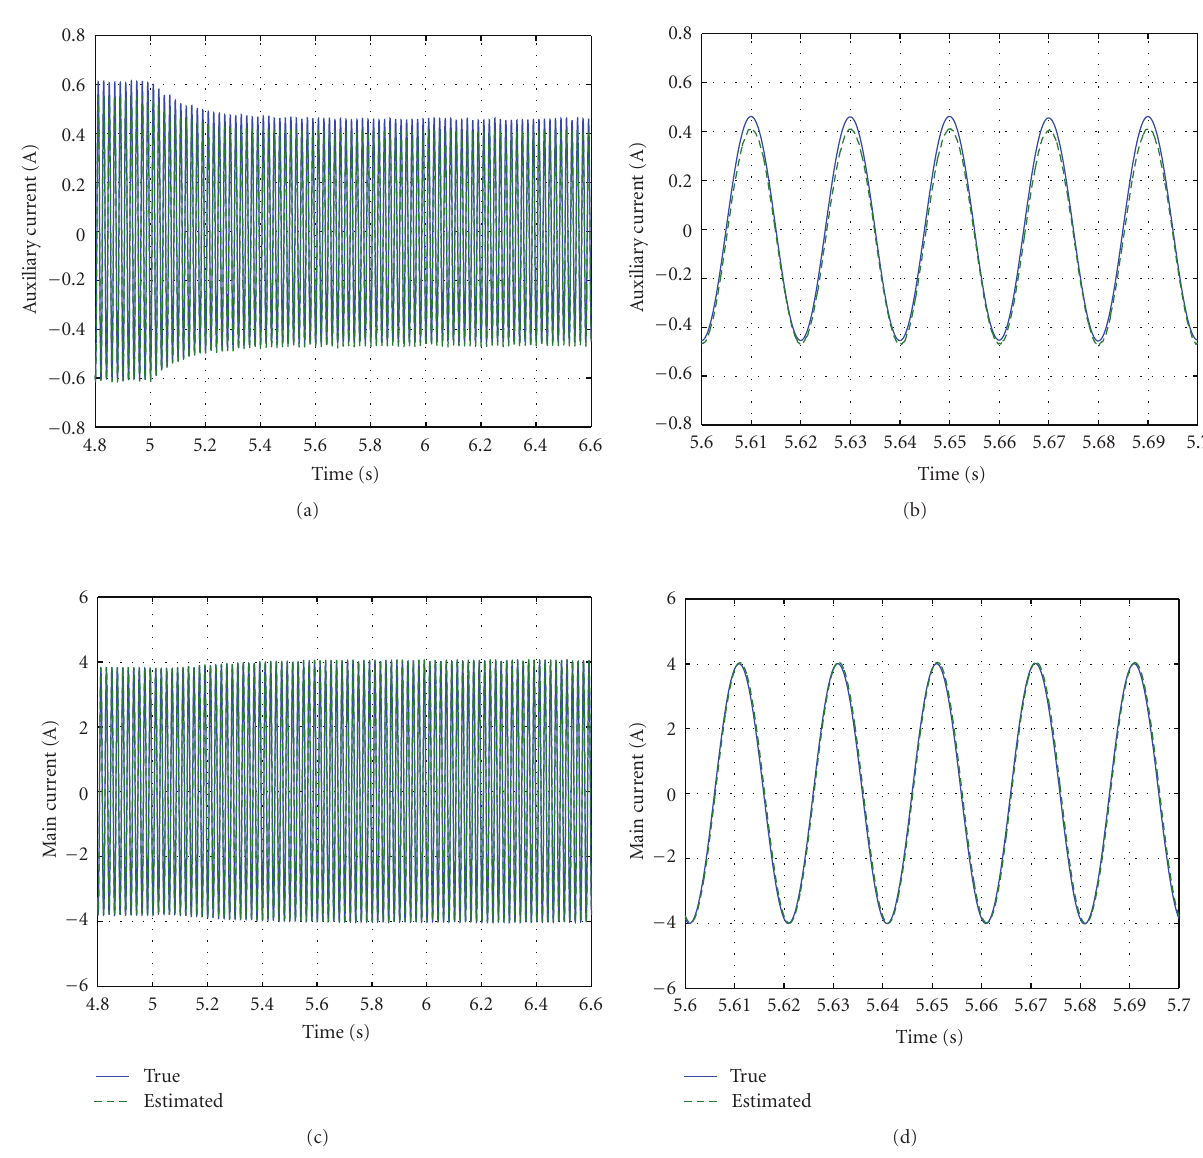
Figure 8: Stator currents of the SPIM and their estimated values for 50 Hz during a load step (computational simulation): (a) auxiliary winding i sα , (b) details of i sα , (c) main winding i sβ , (d) details of i s β